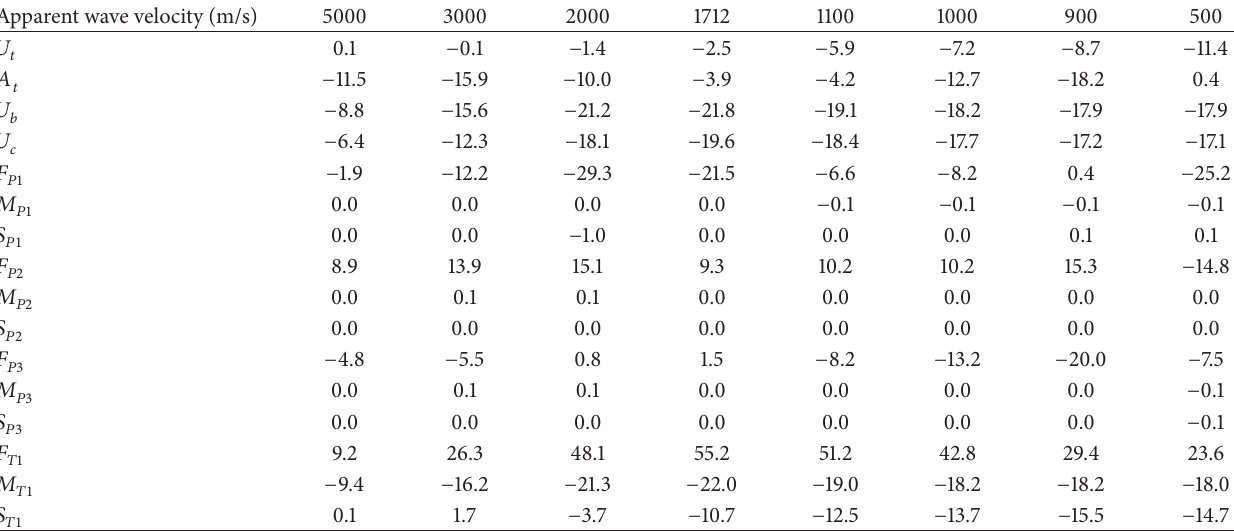
Table 4: Traveling wave effect influence coefficient (%) for seismic responses under excitation of 𝑏 1 . Apparent wave velocity (m/s)